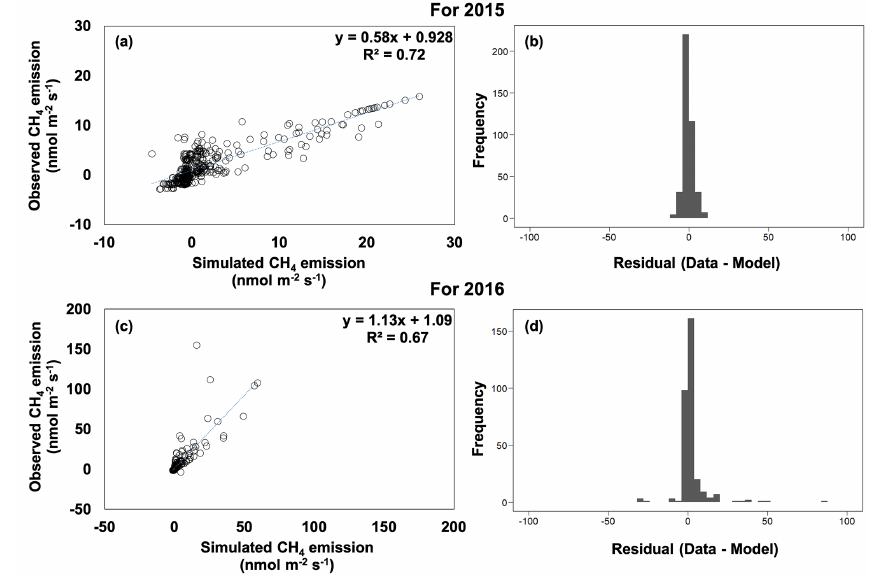
Figure 6. Observed versus simulated methane (CH 4 ) emissions and model residuals for 2015 (a, b) and 2016 (c, d) .